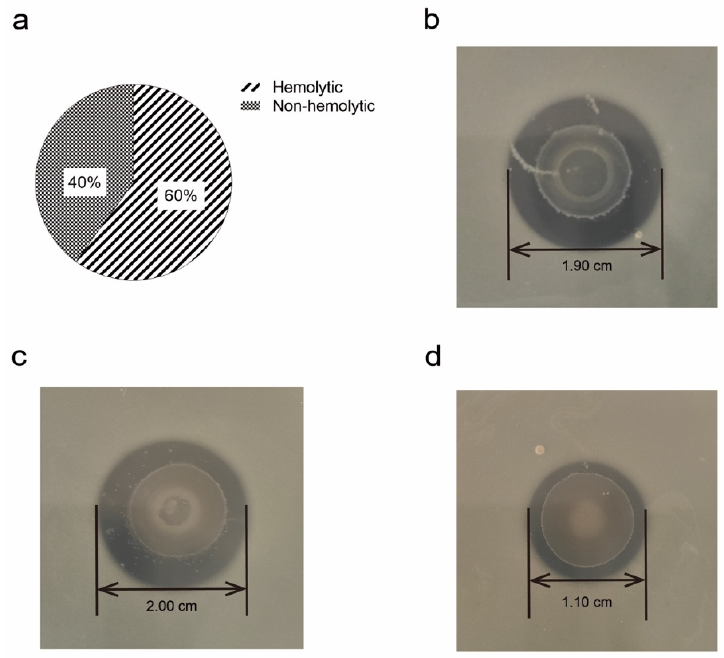
Figure 5. Results of the hemolysis test and agar overlay technique. ( a ) proportion of hemolytic and non-hemolytic Bacillus strains; 60% of Bacillus strains were hemolytic on sheep blood. ( b – d ) are the inhibition zones of B. licheniformis CAU514, CAU495 and CAU511, respectively, with S. aureus ATCC 29213 added in the soft-agar